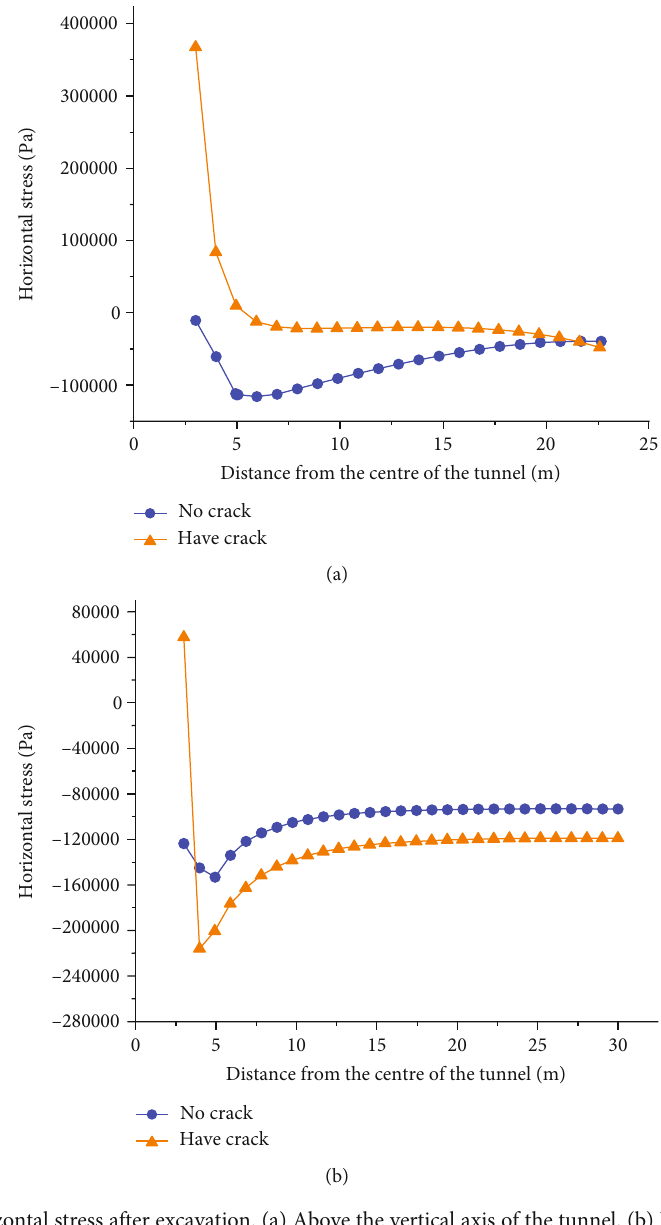
Figure 15: Comparison of horizontal stress after excavation. (a) Above the vertical axis of the tunnel. (b) Right of horizontal axis of